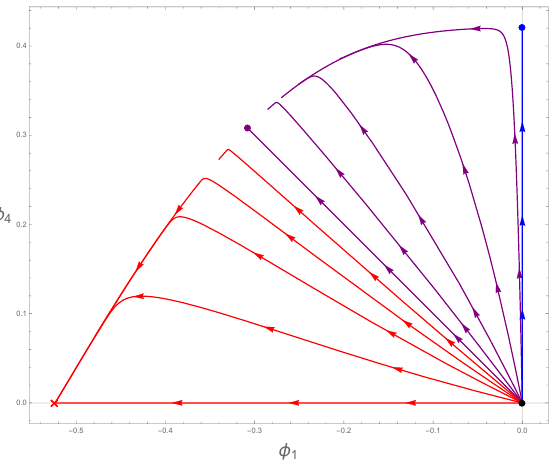
Figure 5 . Parametric plots for the RG flows in the SO(3) invariant 4-scalar truncation. The black dot is the AdS 5 vacuum, the purple dot is the N = 4 , SO(3) × SO(3) invariant AdS 4 × R S-fold solution, while the blue dot is the N = 1 , SU(3) invariant AdS 4 × S 1 S-fold solution. The purple line with φ 1 = − φ 4 is the N = 4 RG flow considered in section 5.1 and the blue line with φ 1 = 0 is the N = 1 RG flow considered in section 5.3. The horizontal red line is the homogeneous GPPZ RG flow, which terminates at a singularity denoted by the red